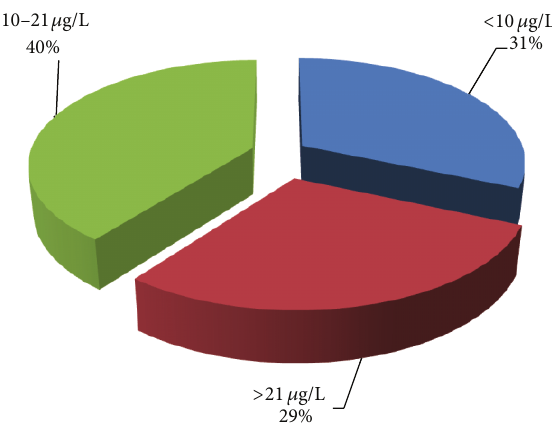
Figure 1: Distribution of 25-(OH) vitamin D 3 levels in study